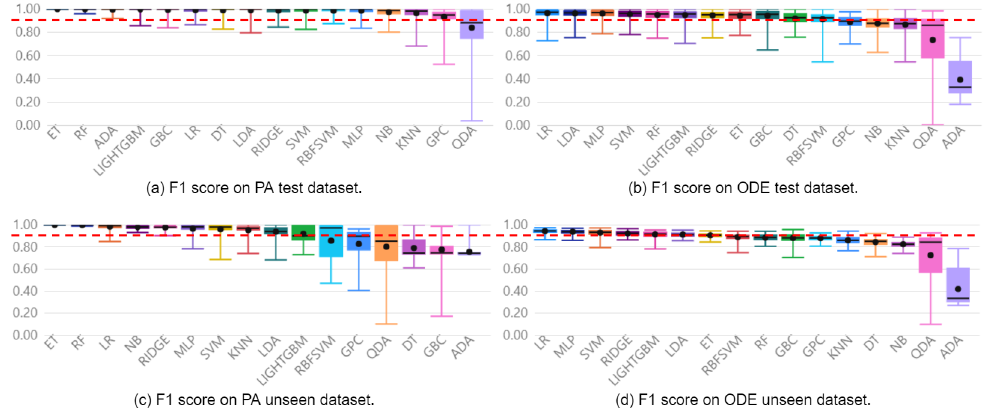
Figure 5. Distribution of F1 Score of Furnace classifiers for Only Discrete Events ( b , d ) and the Proposed Approach ( a , c ).